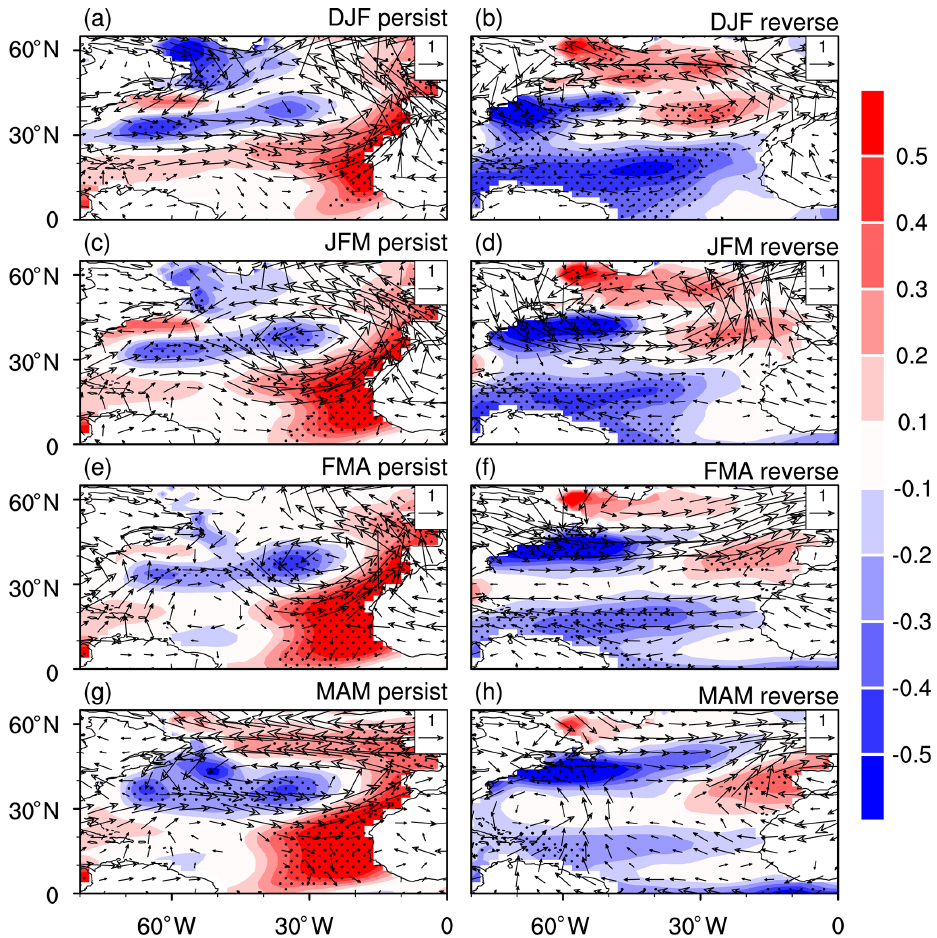
Figure 10. Composite anomalies of SST ( ◦ C) and 850hPa winds (ms − 1 ) in (a, b) DJF, (c, d) JFM, (e, f) FMA, and (g, h) MAM for (left column) the persistent years and (right column) the reverse years. Stippled regions in the figure indicate SST anomalies that are statistically significant at the 5%